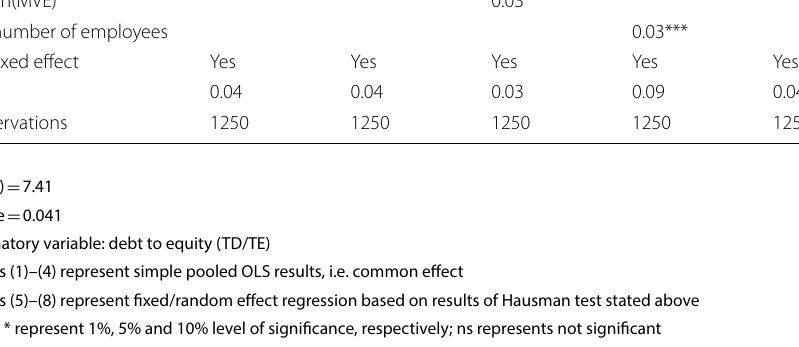
Table 6 Regression analysis of firm size (total asset, total sales, MVE and number of employees) and CAPEX